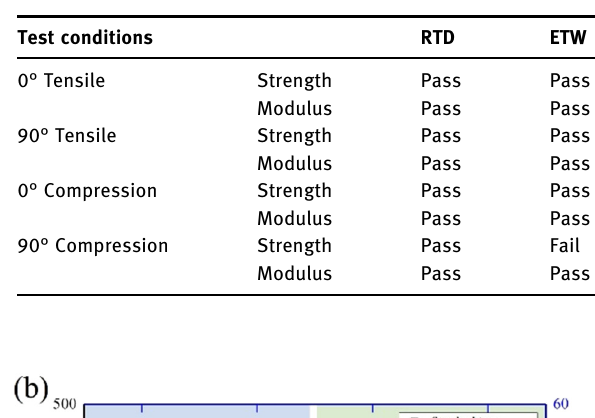
Table 3: Results of second equivalency test applying the Case